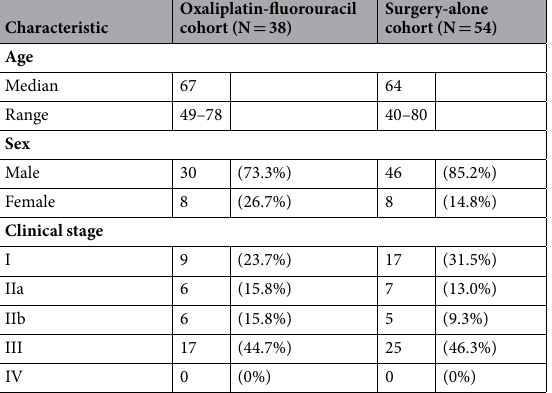
Table 1. Clinical characteristics of patients in the study. Table shows the comparison of age, sex, and clinical stage for the oxaliplatin-fluorouracil treated patients in the clinical trial, and a separate cohort of patients treated with surgery